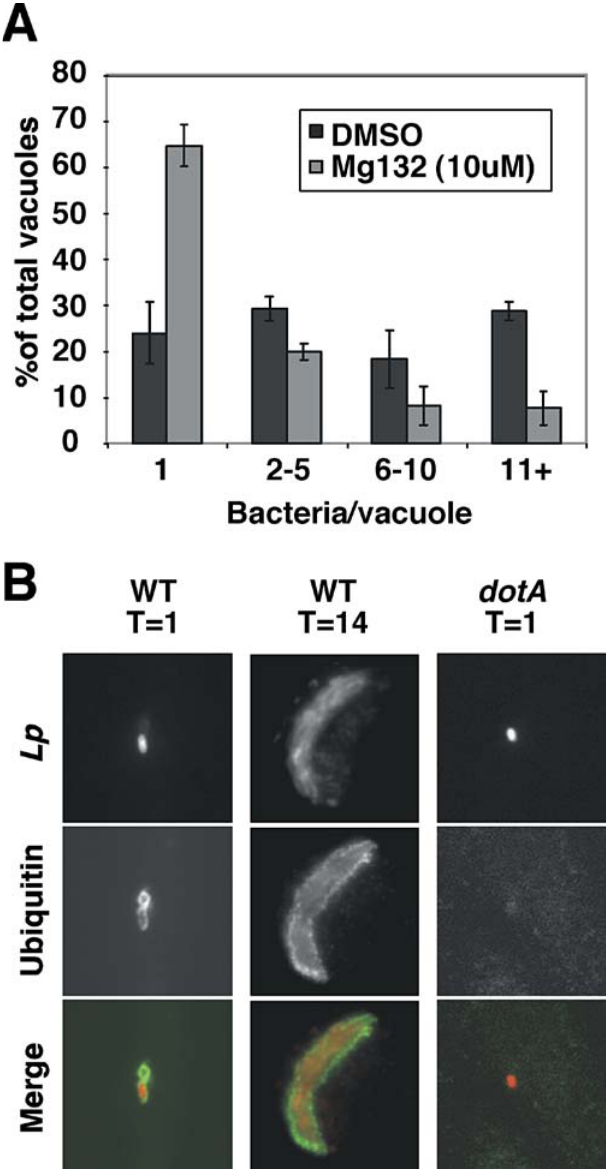
Figure 4. The Proteasome Promotes L. pneumophila Replication and Translocation of Bacterial Effectors causes Ubiquitination of the LCV (A) Mouse BMDMs were pretreated for 1 h with proteasome inhibitor MG-132 or DMSO, incubated with L. pneumophila for 1 h at MOI ¼ 1, washed, and incubated for 14 h. Infectious centers assay was performed as described. (B) Mouse BMDMs were incubated with L. pneumophila for 1 h at MOI ¼ 1, fixed at the indicated time, and immunostained with antipolyubiquitin and anti– L. pneumophila. DOI: